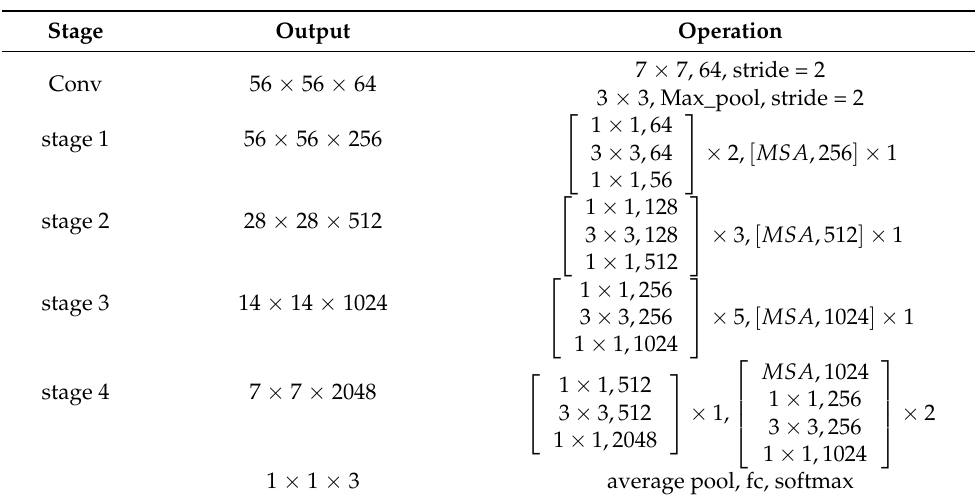
Table 1. The structure details and specific parameters of the BoT-ViTNet